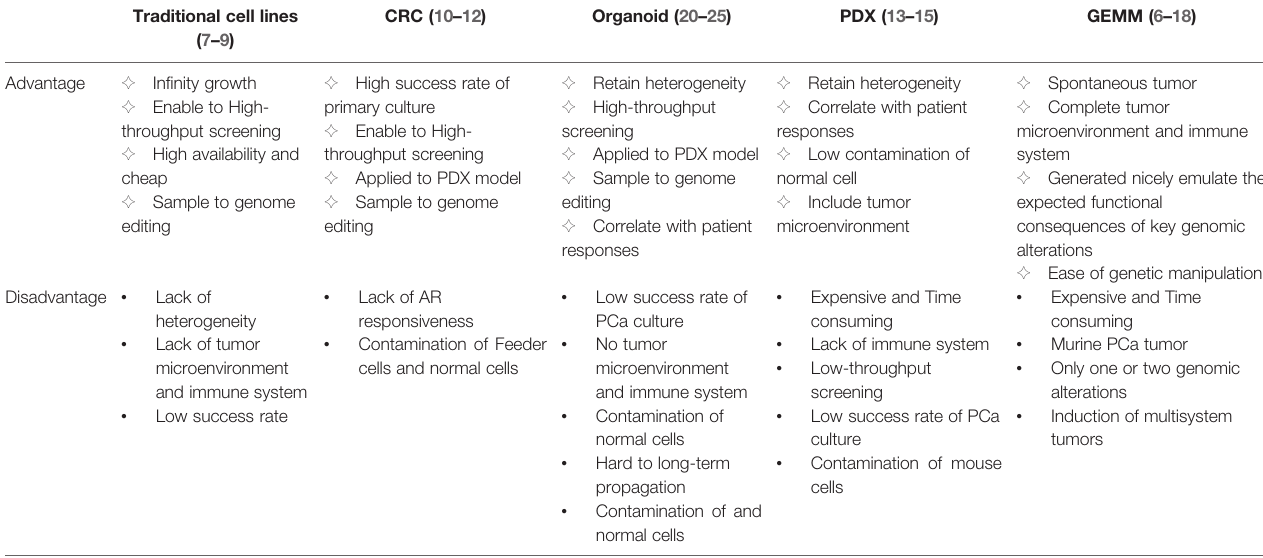
TABLE 1 | Comparison of different prostate cancer model